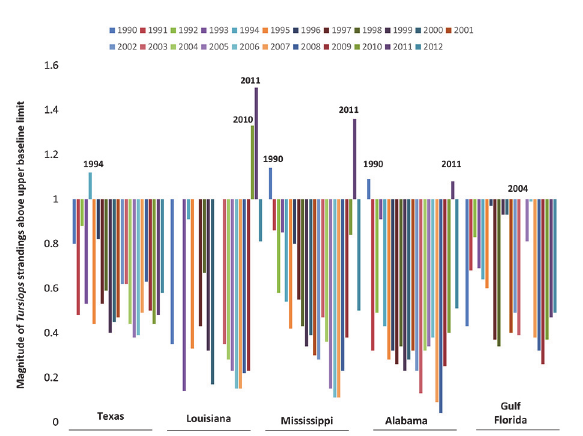
Fig 2. Magnitude of annual common bottlenose dolphin ( Tursiops truncatus ) strandings by state and year above the 95 th baseline quantile (1990 – 2009) in the Gulf of Mexico, 1990 to 2012. State-years with dolphin stranding numbers equal to or greater than ‘ 1 ’ are considered large scale mortality years (LSMYs). Louisiana annual stranding data were not included for 1991 – 1992 and 2001 – 2002 for Louisiana due to inadequate stranding response coverage during those